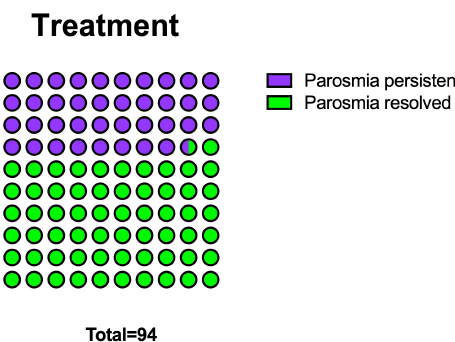
Figure 3. Comparison between the patients who recovered from parosmia in treatment group and in control group; the di ff erence was not statistically signi fi cant ( χ : p = 0.3).